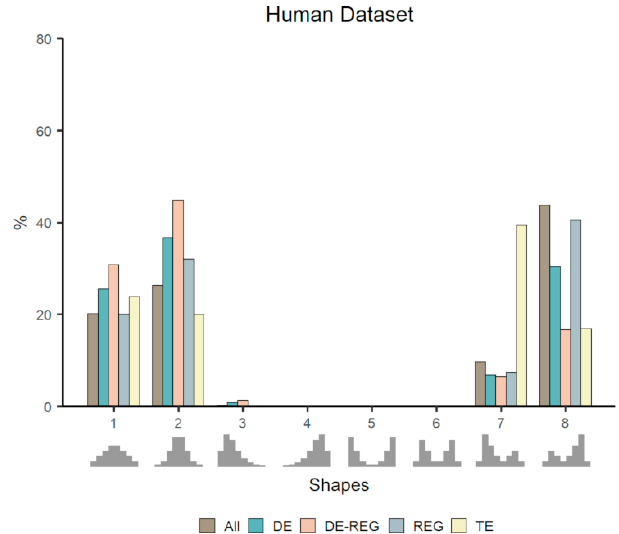
Figure 5. Proportion of genes falling in each template shape in the human dataset. The proportion of genes classified as DE, REG, or DE-REG are compared to the overall (All) proportion of genes within each shape.